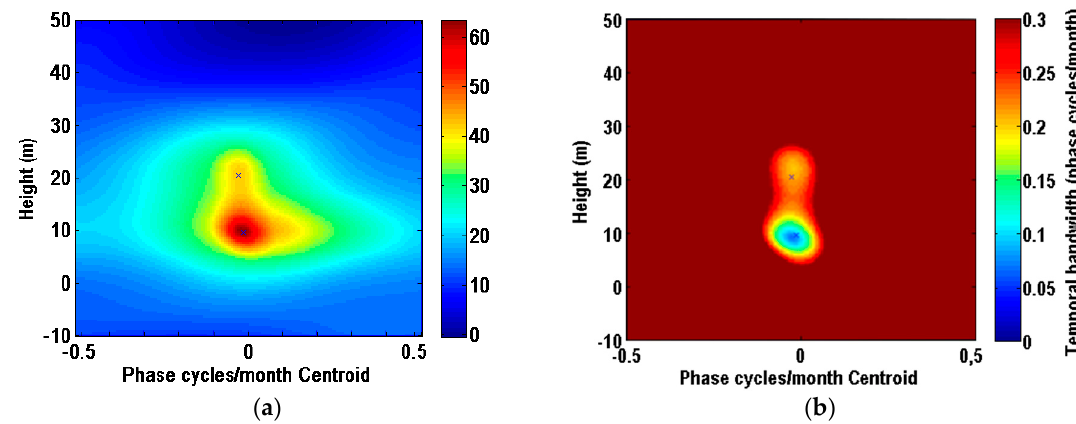
Figure 3. Gen. Capon 5D Diff-Tomo elevation-temporal frequency centroid functional, P-band forested cell: ( a ) robust output power; and ( b ) fit temporal bandwidth.